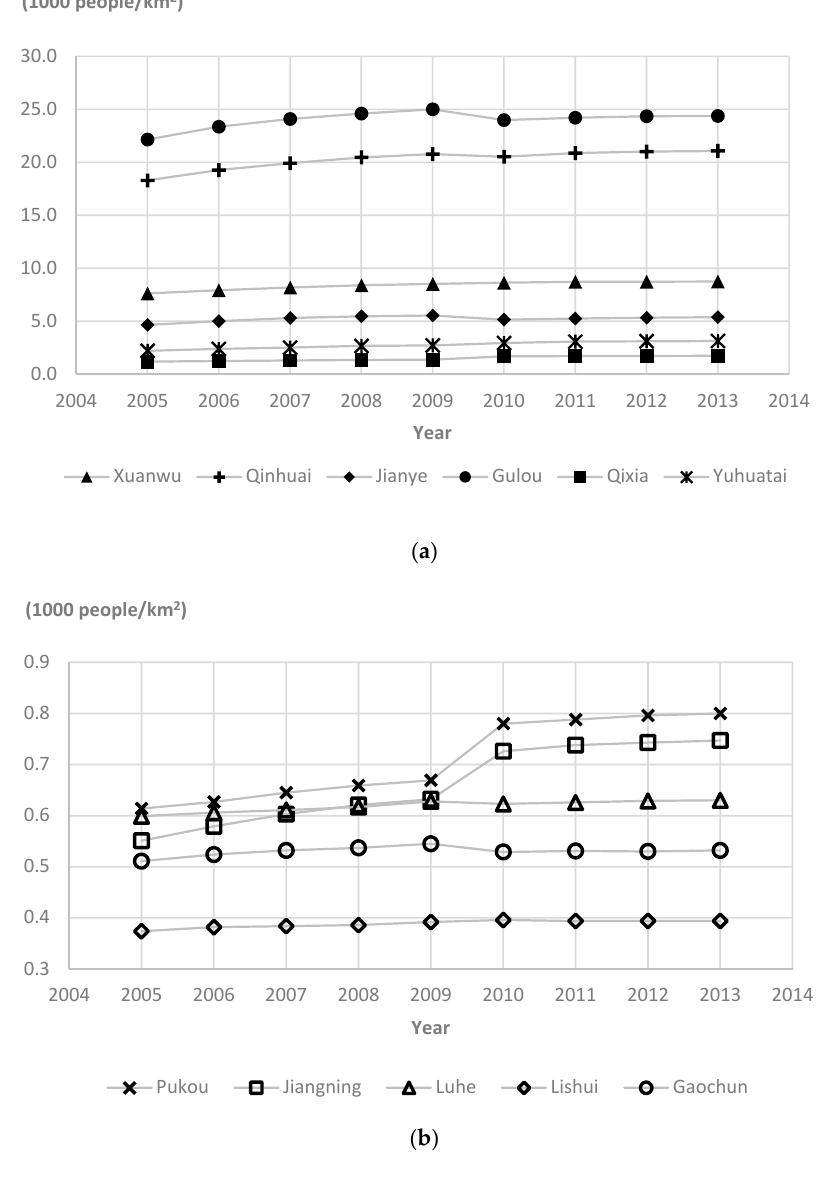
Figure 3. Variations of population density in urban districts (2005–2013): ( a ) city proper and ( b ) suburbs.